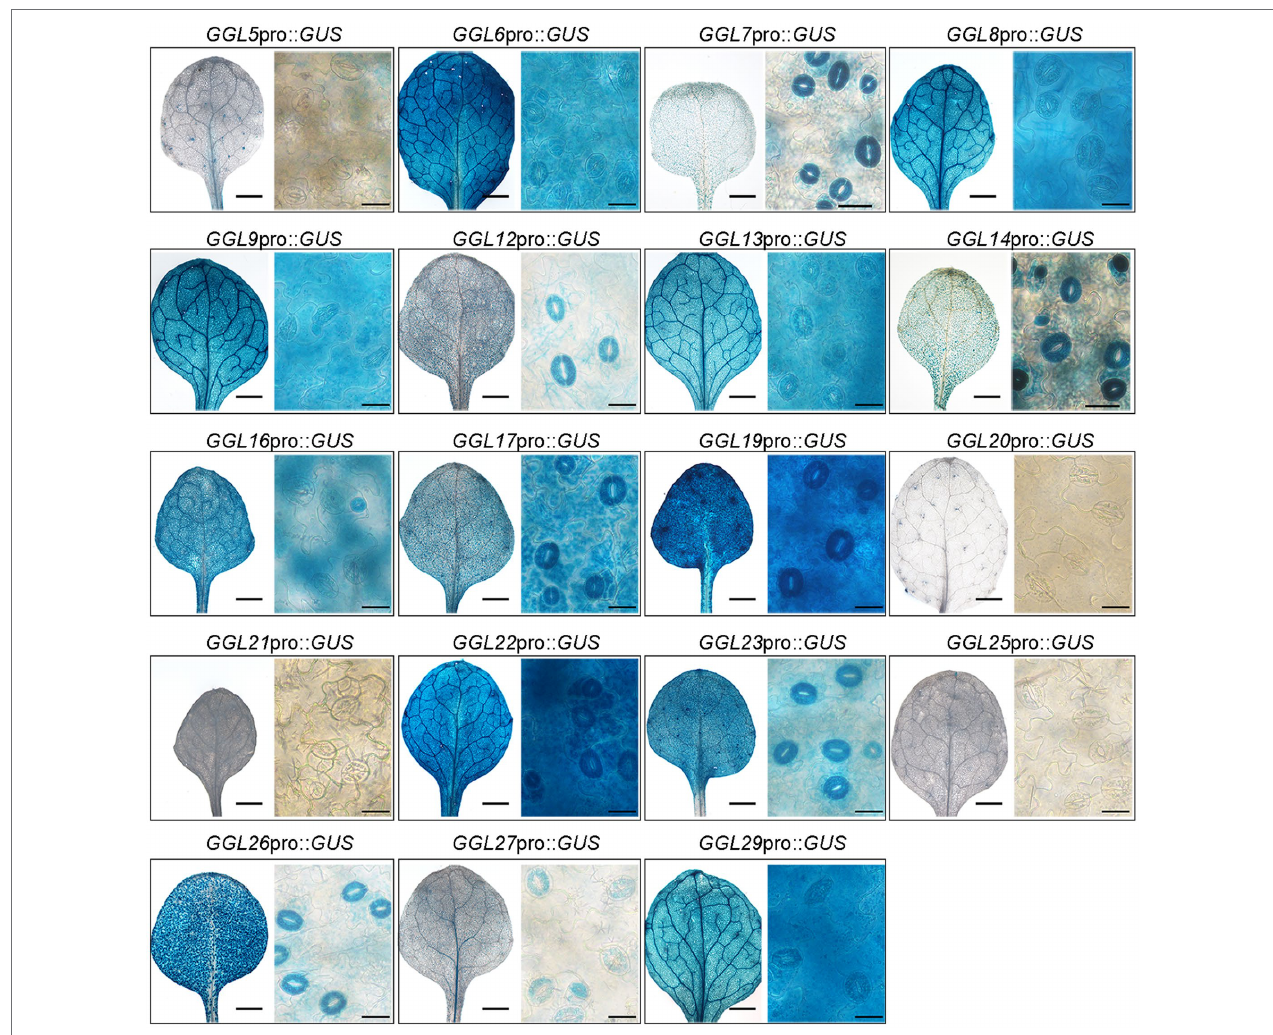
FIGURE 3 | Expression profiles of 19 GGLs in 14-DAG true leaves. The true leaves of 14-DAG GGL pro:: GUS expressing seedlings were stained with X-Gluc. For each gene, the images from left to right represent a true leaf from a 14-DAG seedling (scale bar = 1 mm) and an enlarged part of it (scale bar = 25 μ